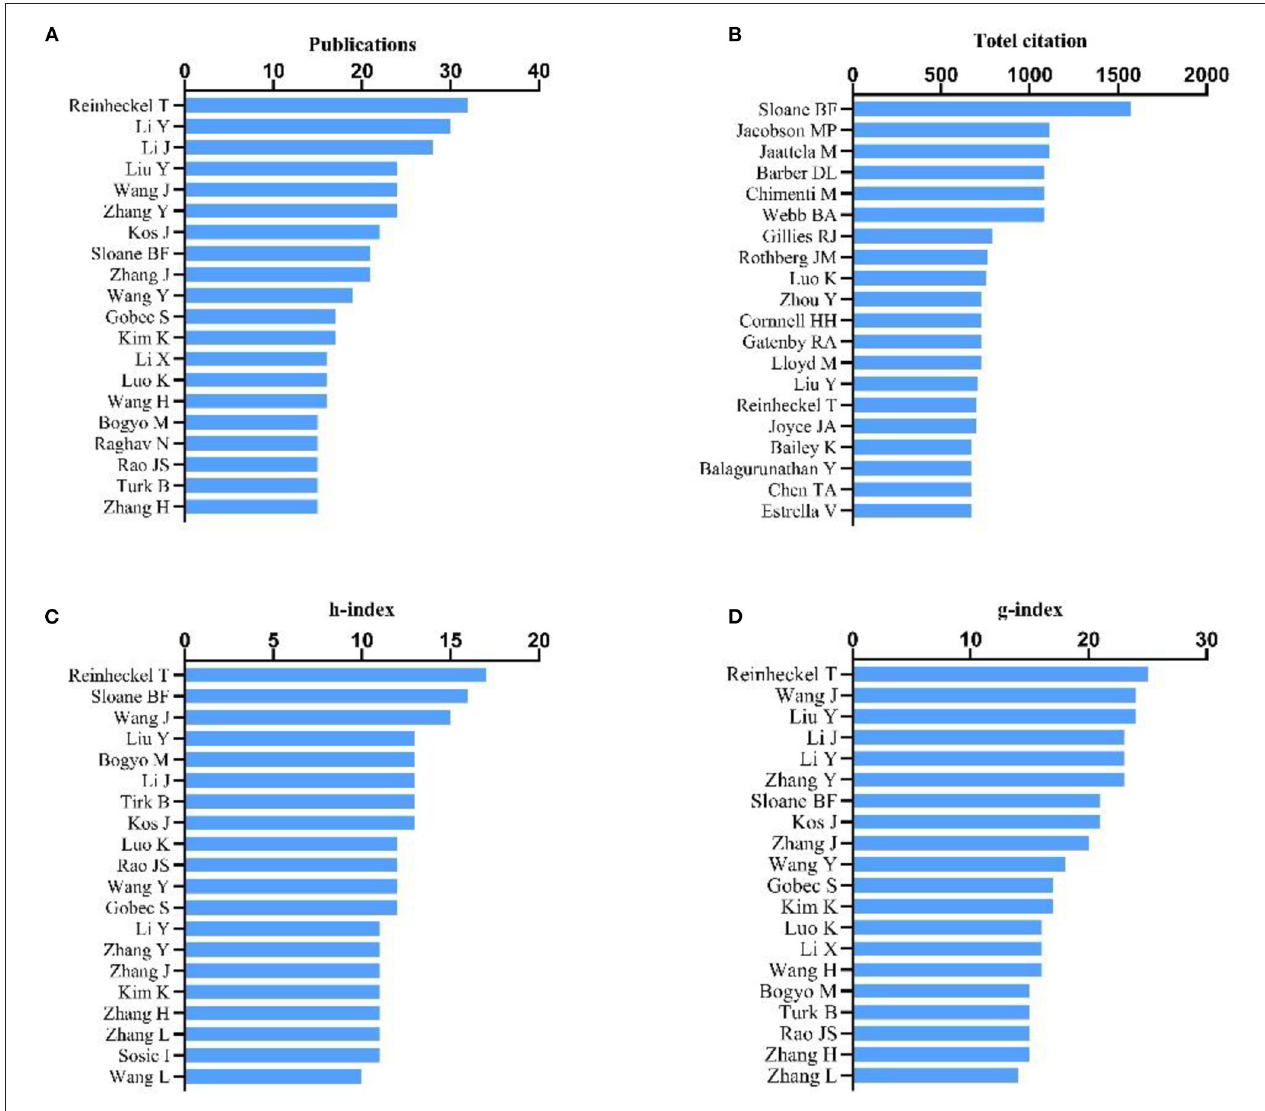
FIGURE 3 | Analysis of authors. (A) Number of publications from different authors; (B) Total citations in the research field from different authors; (C) h-index of publications from different authors; (D) g-index of publications from different